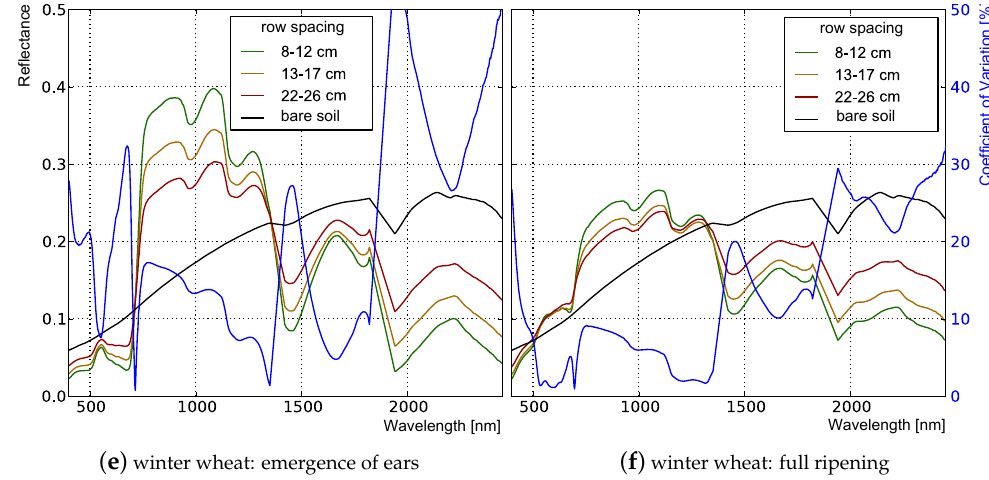
Figure 5. Influence of row spacing on top-of-canopy reflectance of ( a , b ) winter barley; ( c , d ) winter rye and ( e , f ) winter wheat during ( a , c , e ) emergence of ears, and ( b , d , f ) full ripening. The blue line corresponds to the coefficient of variation of the plotted spectra.